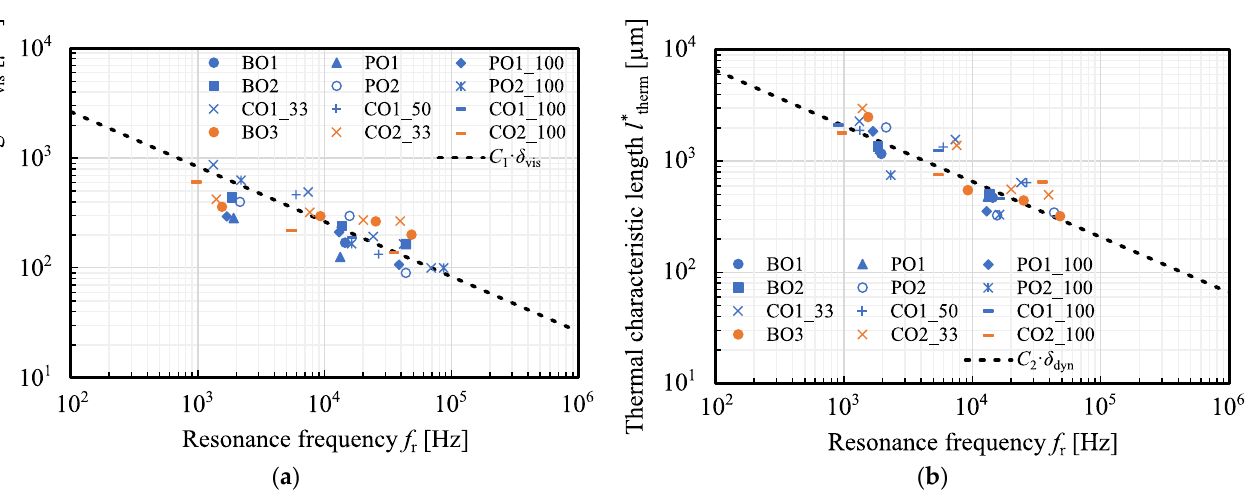
Figure 7. Determined characteristic length of the viscous damping ( a ) as well as of the thermodynamic damping of the transitional flow regime ( b ). In both cases, a multiple of the viscous or thermal boundary layer thickness is included ( C 1 = 12, C 2 = 25).